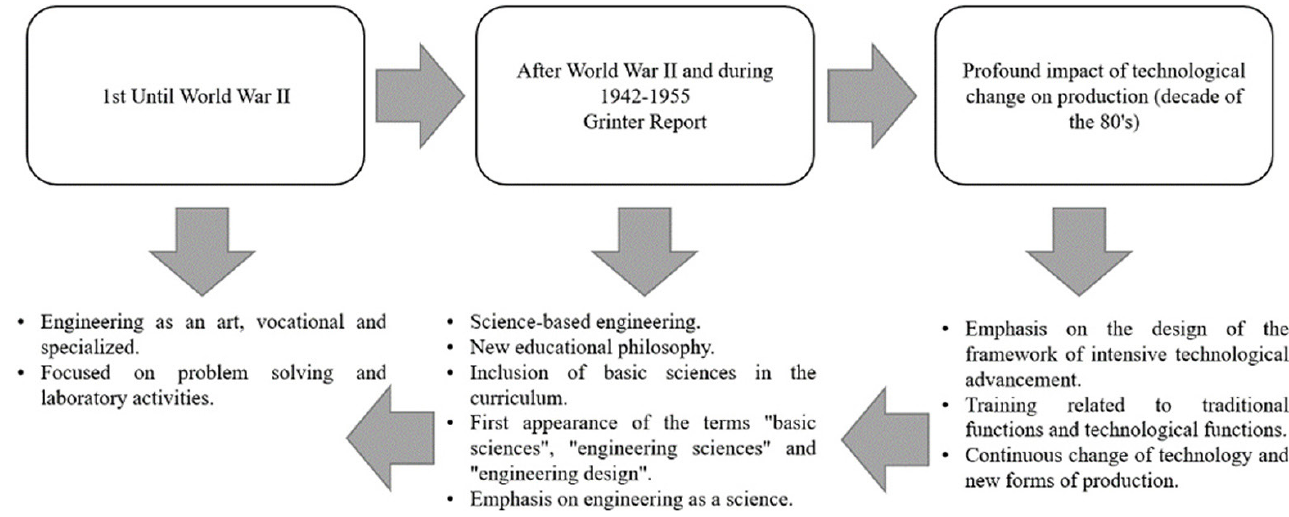
Fig. 1. Periods of engineering in Latin America. created by the authors based on Vargas